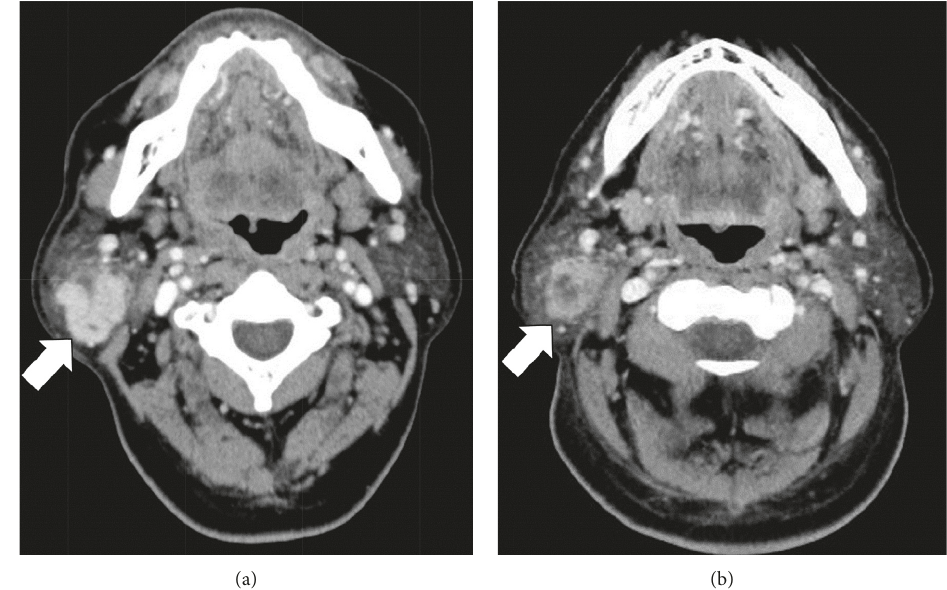
Figure 1: Postcontrast computed tomography (CT) findings. The right parotid gland tumor in scans obtained in our hospital (b) is smaller than that in scans obtained in our affiliated hospital (a).